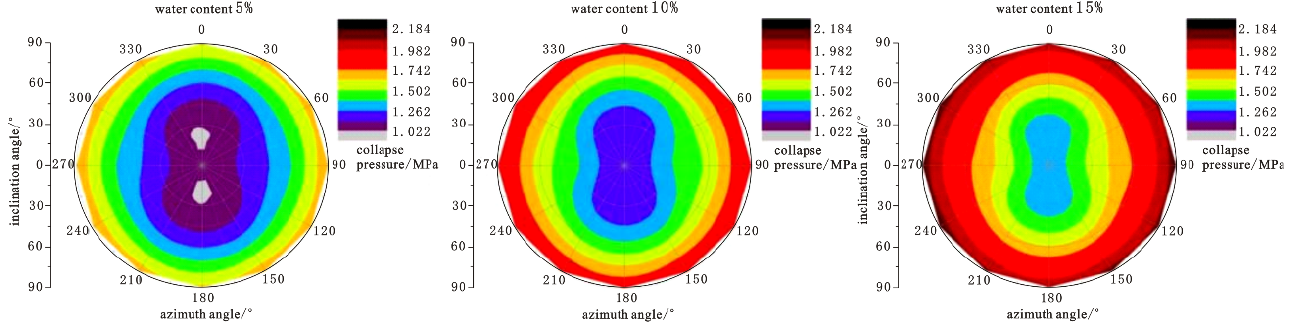
Figure 3. Nephogram of collapse pressure distribution under different well types and water content.